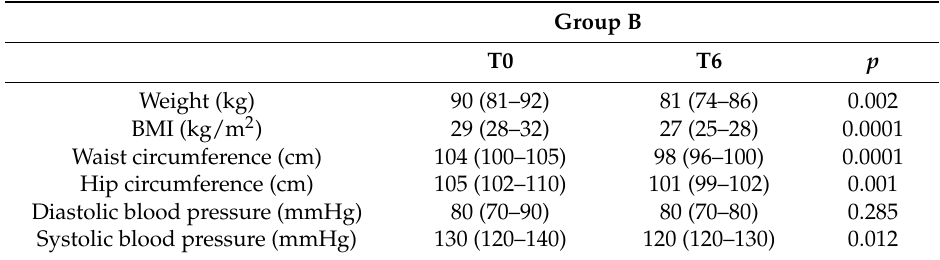
Table 3. Comparison of anthropometric, biochemical and clinical features at baseline (T0) and after six months (T6) of treatment in patients following a low-calorie diet in association with the Bilirel (BIL) complex (Group